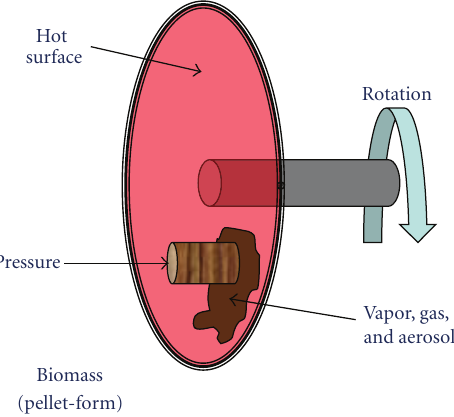
Figure 6: Ablative biomass pyrolysis reactor concept.